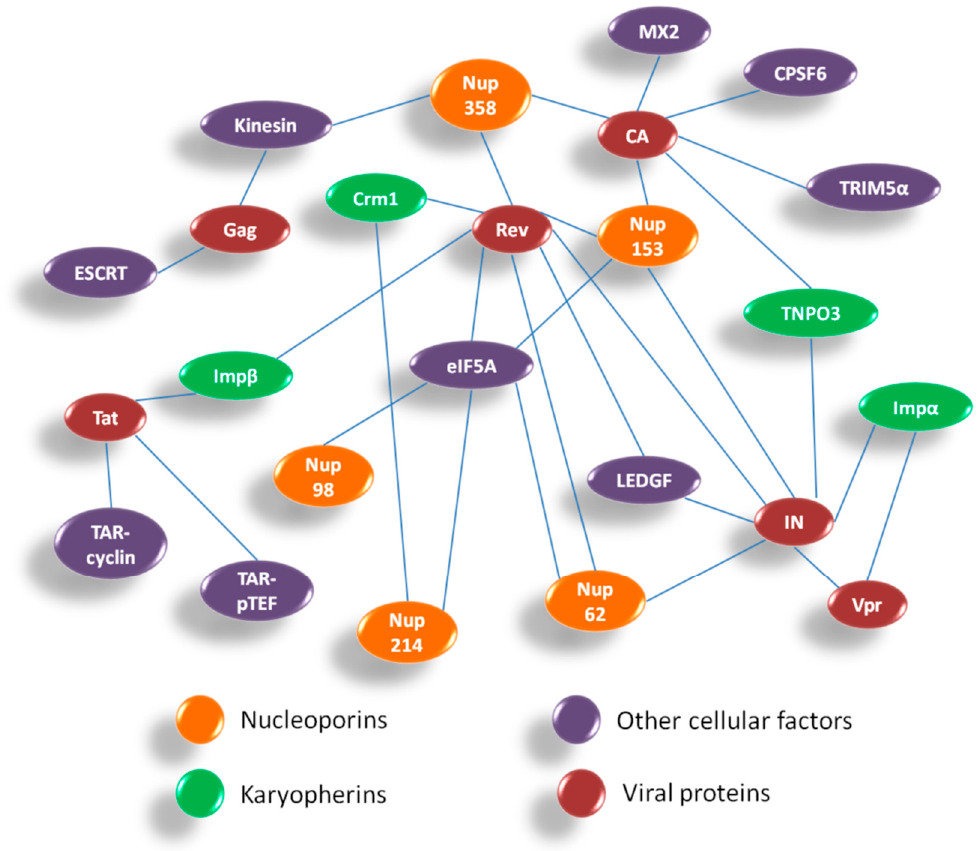
Figure 7. Host-HIV-1 interactome during nuclear import and export of HIV-1 at a